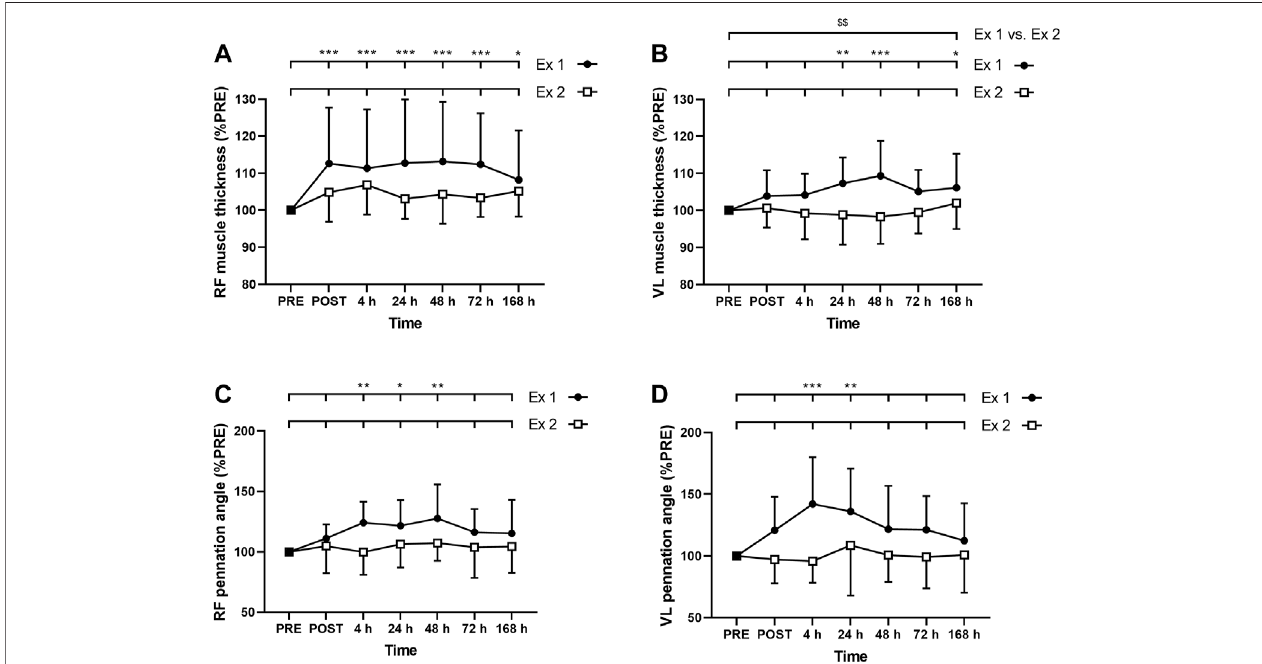
FIGURE5| Timecourseof (A) rectusfemoris (RF)and (B) vastuslateralis (VL)musclethickness,and (C) RFand (D) VLpennationangleforexercise1andexercise 2. *, ** and *** correspond to signi fi cant difference from PRE value at p < 0.05, p < 0.01 and p < 0.001, respectively. $$: signi fi cant difference between exercise 1 and exercise 2 at p < 0.01.